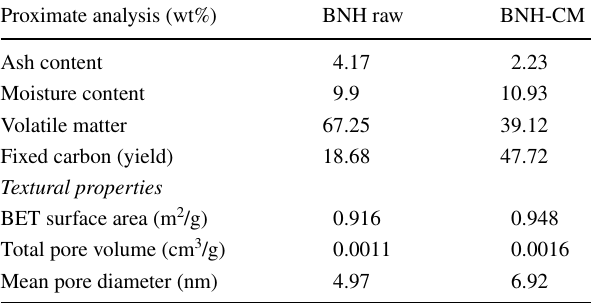
Fig. 1 N2 adsorption–desorption isotherms of